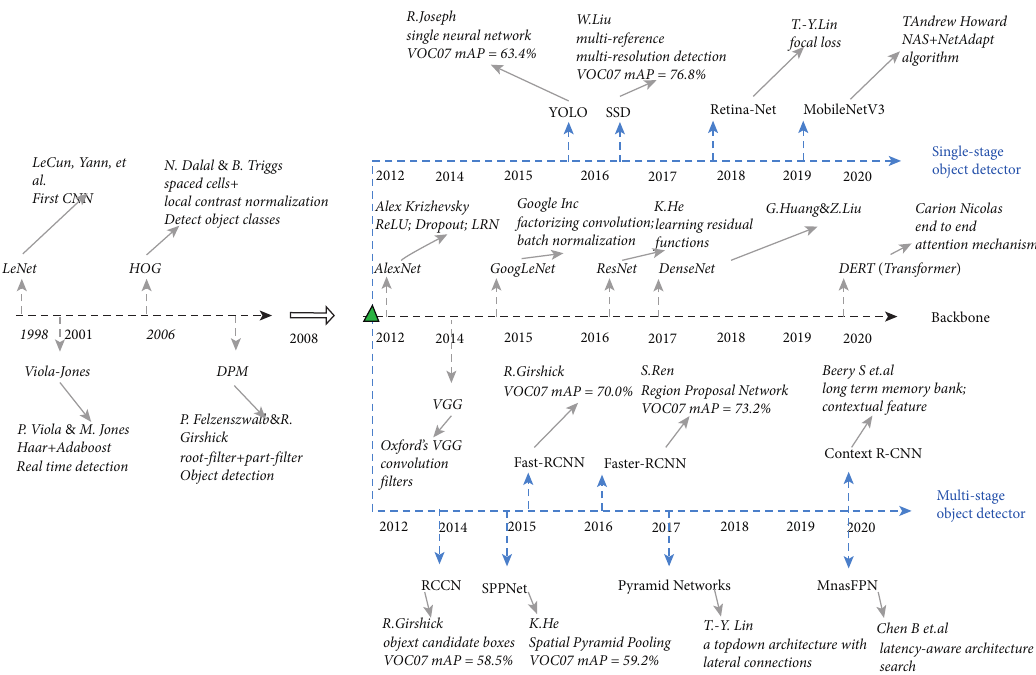
Figure 2: Deep learning-based visual perception development of neural network backbone and object